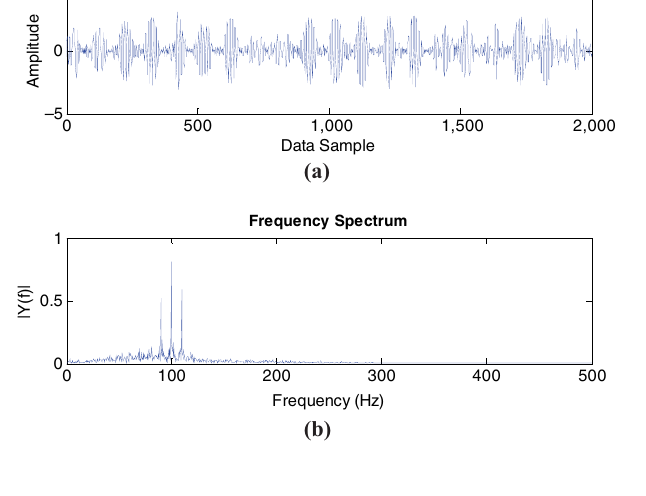
Figure 5. A designed experimental platform and industrial railway axle bearing faults: (a) the designed experimental platform; (b) the outer race fault; (c) the inner race